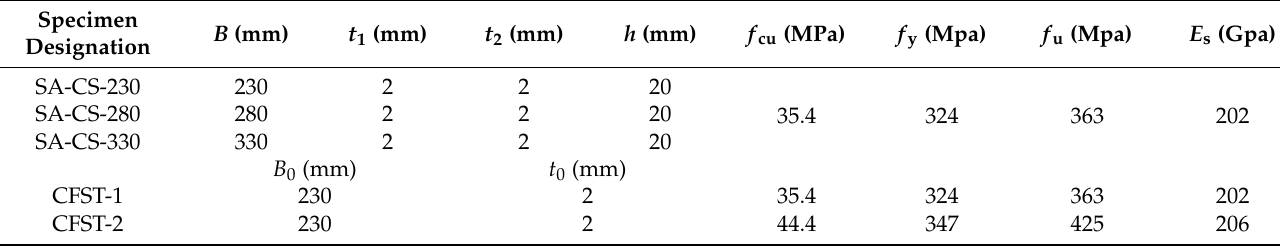
Figure 3. Waveform and cross-section of SA-CS column. Table 1. Design parameters of specimens.